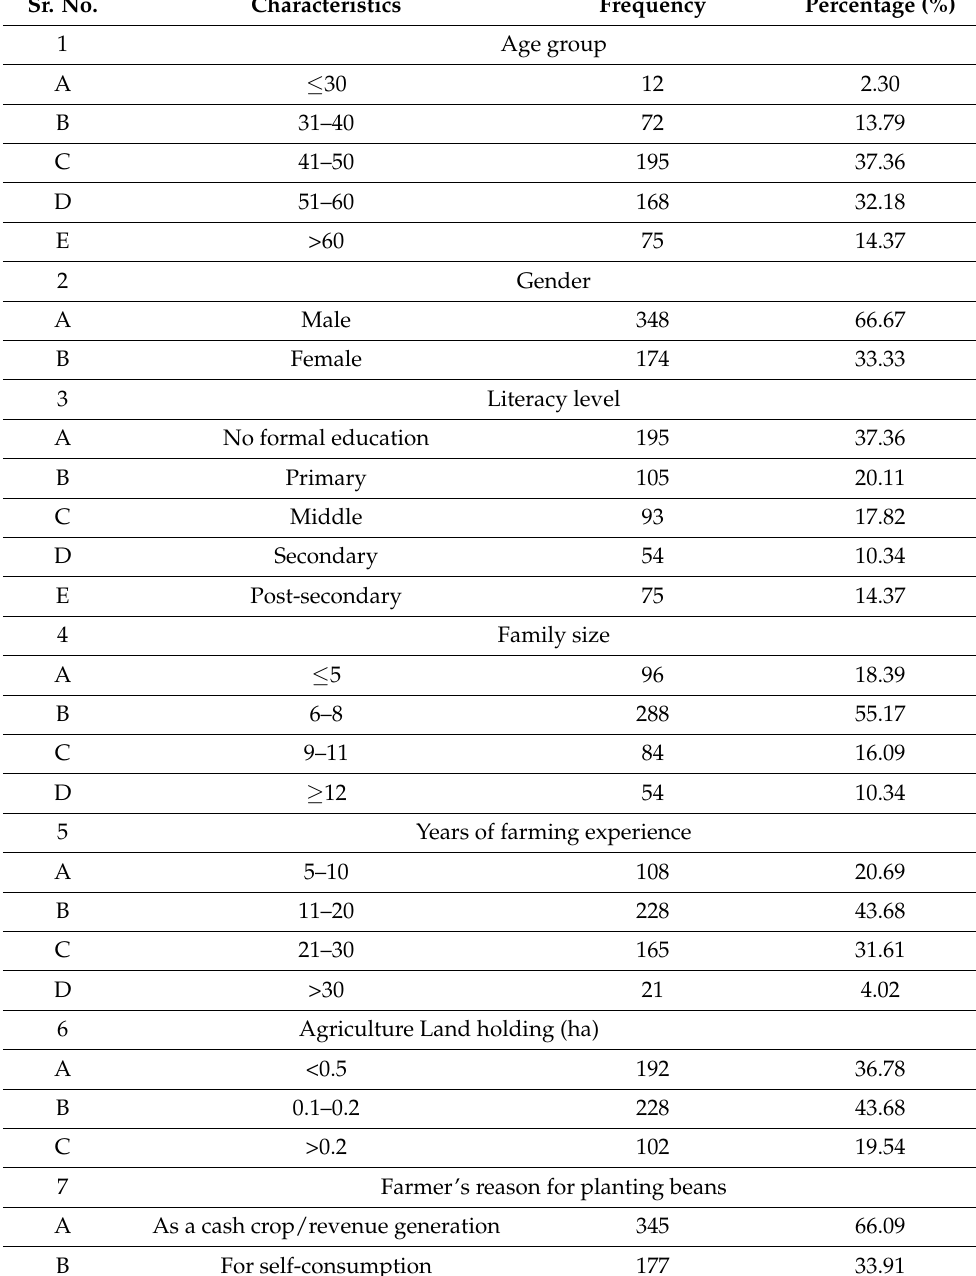
Table 1. Socioeconomic variables recorded from the common bean cultivating populations in the study area including age group, family size, literacy rate, land holding and perceptions (respon- dents: 522). Sr. No.